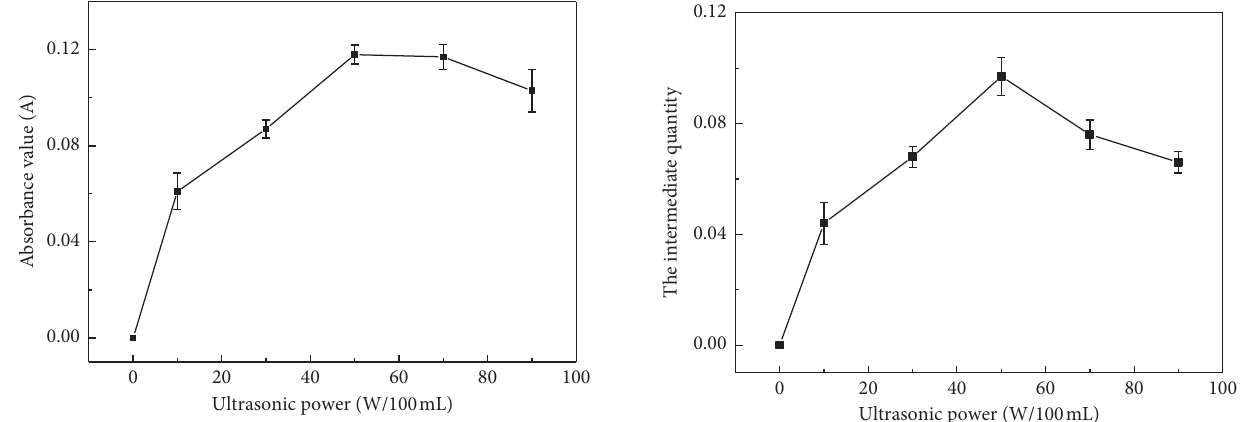
Figure 10: The effect of ultrasonic power on intermediate